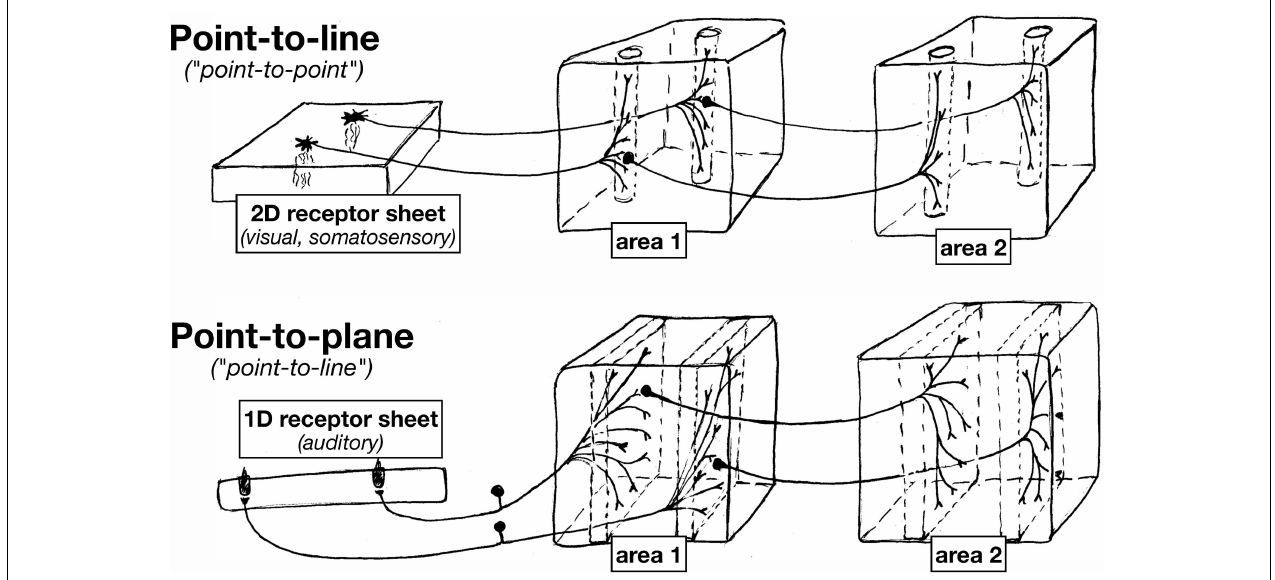
FIGURE 3 | Since auditory receptors form a 1D line, in contrast to 2D sheets of visual and somatosensory receptors, subsequent approximately topological station-to-station connections between nuclei in the auditory system have an ‘extra’ dimension across which to